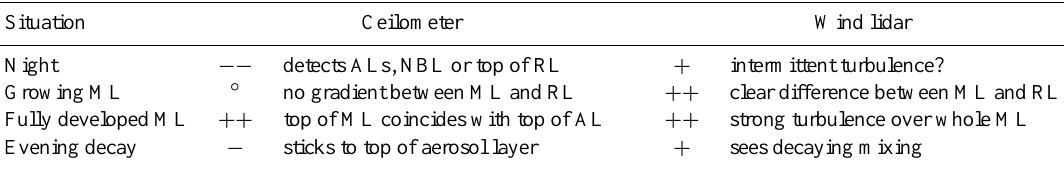
Table 4. Comparison of the capabilities of the MLH retrievals in different situations. AL, aerosol layer; ML, mixing layer; NBL, nocturnal boundary layer; RL, residual